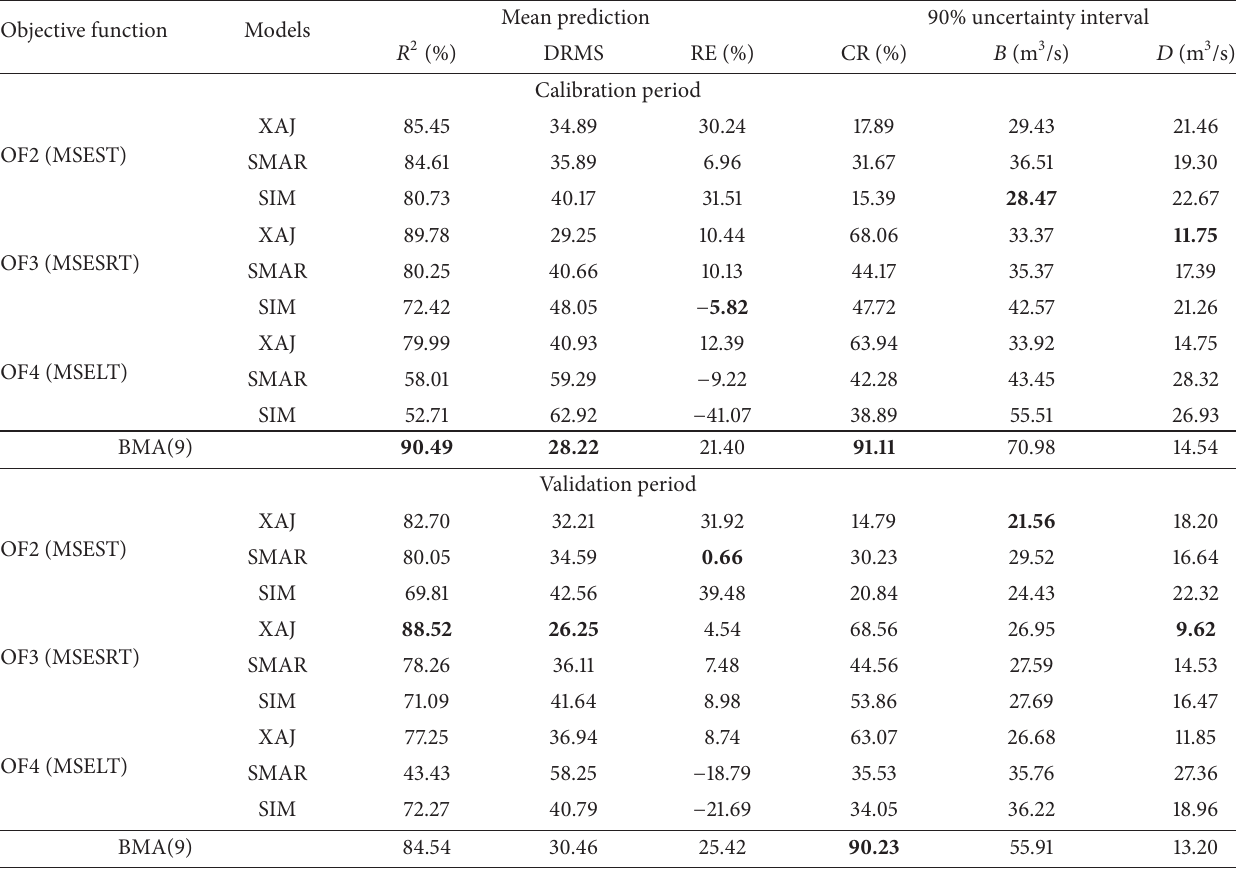
Table 2: Results of BMA(9) and its 9 individual models in the mean prediction and 90% uncertainty interval for the whole flow series. Objective function